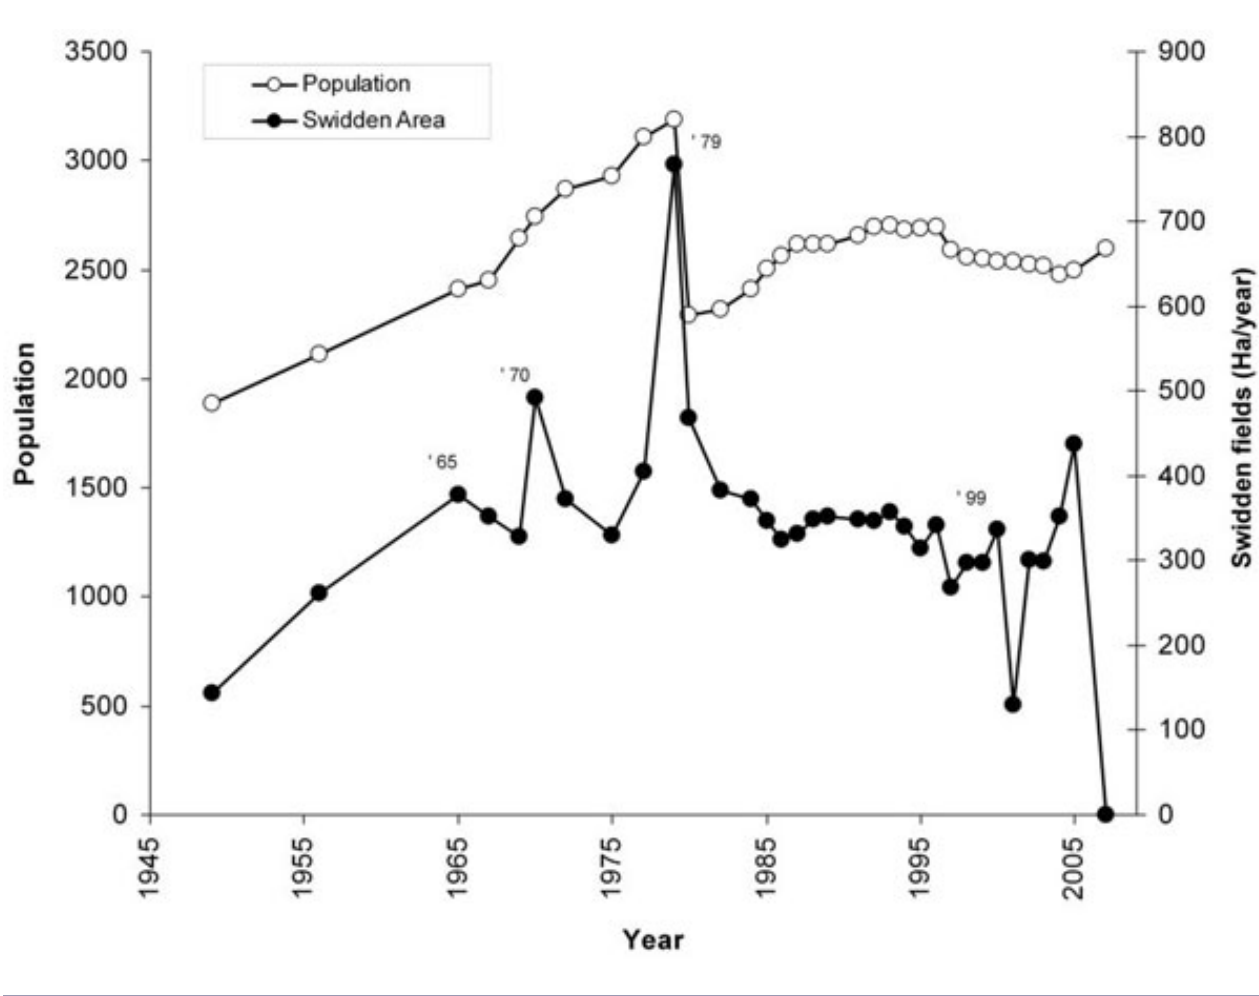
Figure 4. Impacts of policy changes on swidden cultivation in